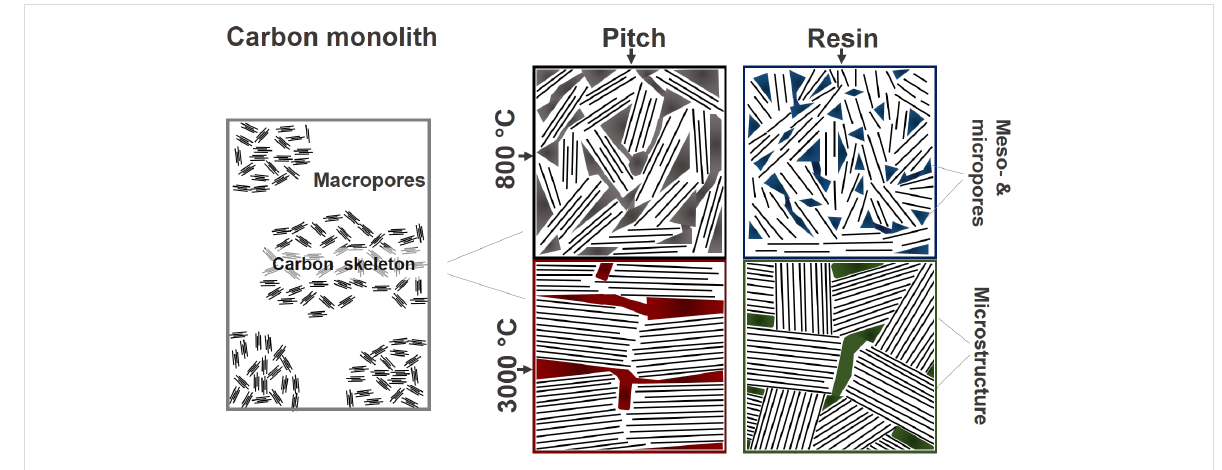
Figure 8: Structural evolution of the different carbon materials in the empty state in comparison to the bulk (non-templated) resin treated at the same temperatures (800 and 3000 °C).